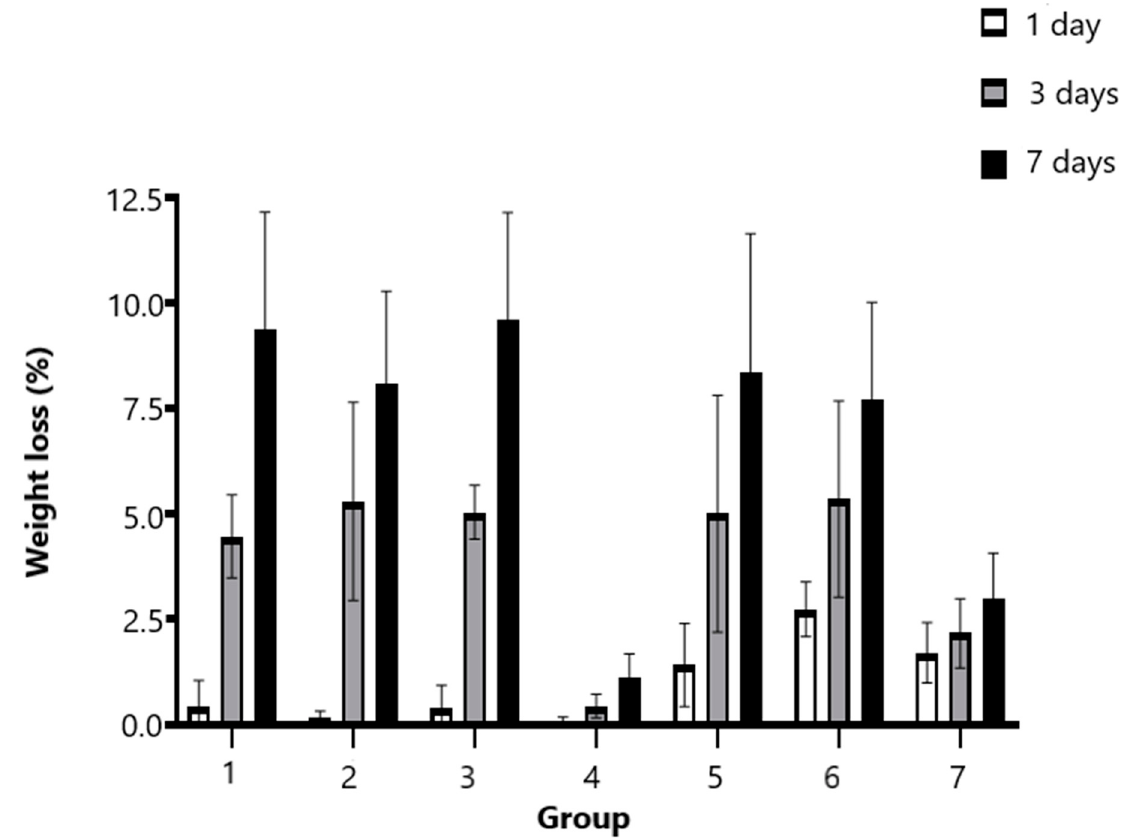
Figure 2. Glass ionomer cements: representation of weight loss after acid challenges.